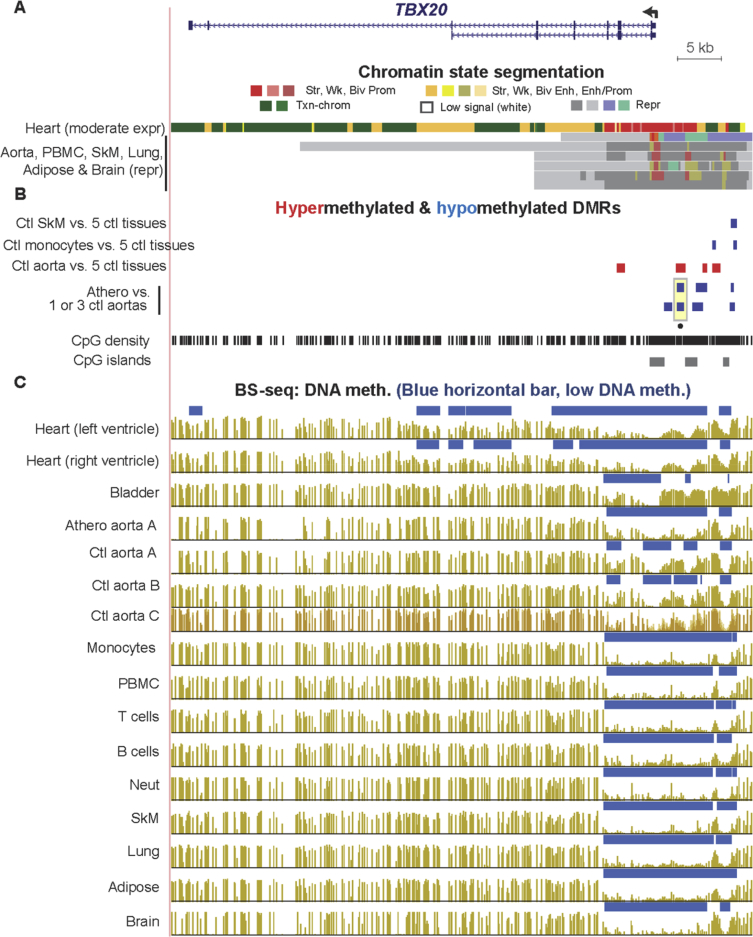
Atherosclerosis-associated hypomethylation at the 5′ end of the differentiation-linked TF-encoding gene TBX20. These DMRs are observed even though the gene is fully repressed in normal aorta and most postnatal tissues. (A) RefSeq gene isoforms and chromatin state segmentation (chr7:35,240,087-35,304,318). (B) Tissue-specific and atherosclerosis-associated DMRs. (C) Bisulfite-seq DNA methylation profiles. Note that the uppermost chromatin state track is from heart, one of the few TBX20-expressing postnatal tissues (Table 5).